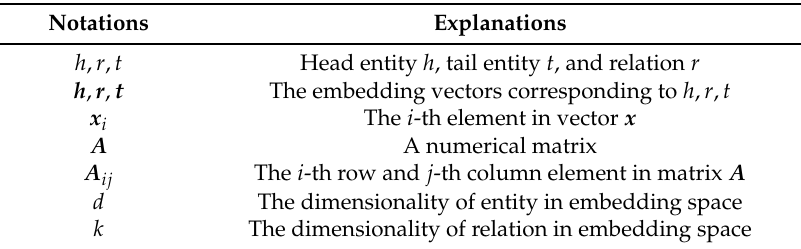
Table 1. Detailed explanation of